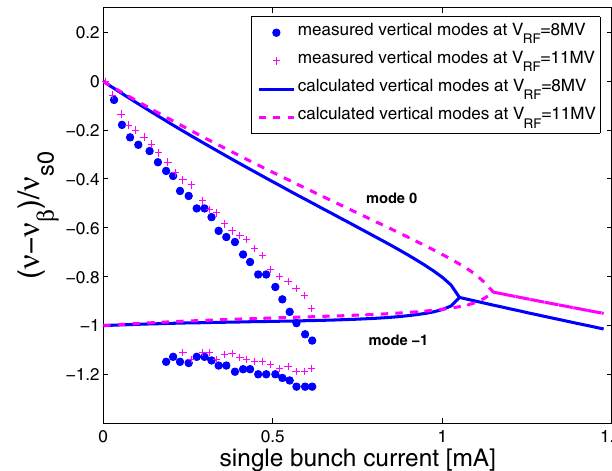
FIG. 16. (Color) The different contributions to the (cid:1) -weighted vertical and horizontal kick factors (synonym to the tune shifts apart from a constant factor) at a bunch length of 5